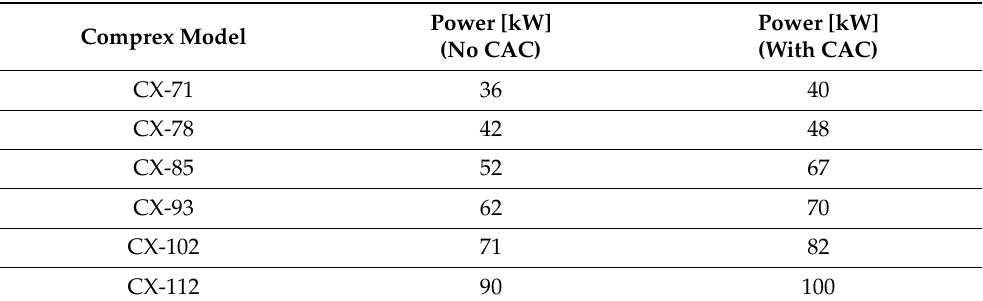
Table 3. Max. engine power charged with Comprex models, with or without air intake cooling (1980’s) [22].